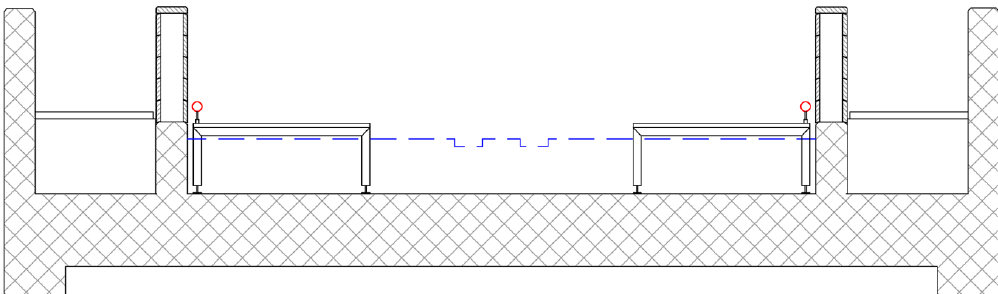
Figure 2. Cross section of the inrun; the guiding tubes are colored red.